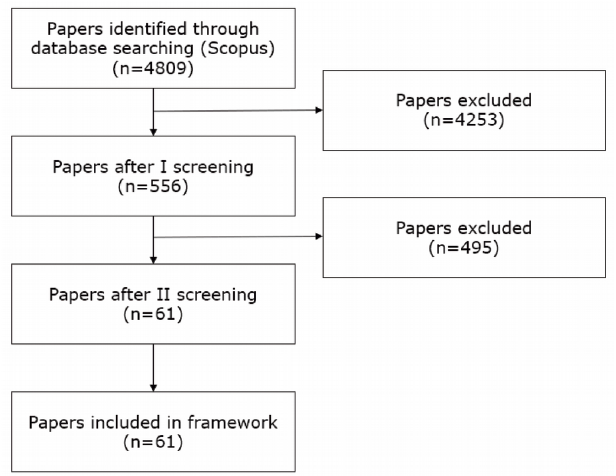
Figure 1. Systematic Literature Review